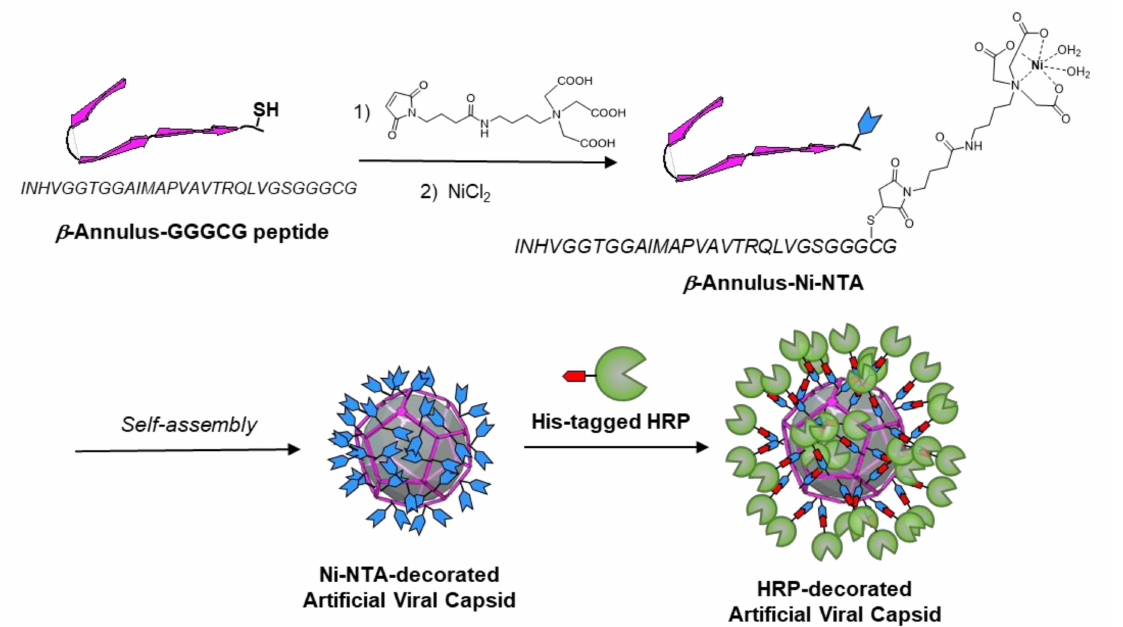
Figure 1. The self-assembly of artificial viral capsids decorated with Ni-NTA and horseradish peroxidase (HRP).